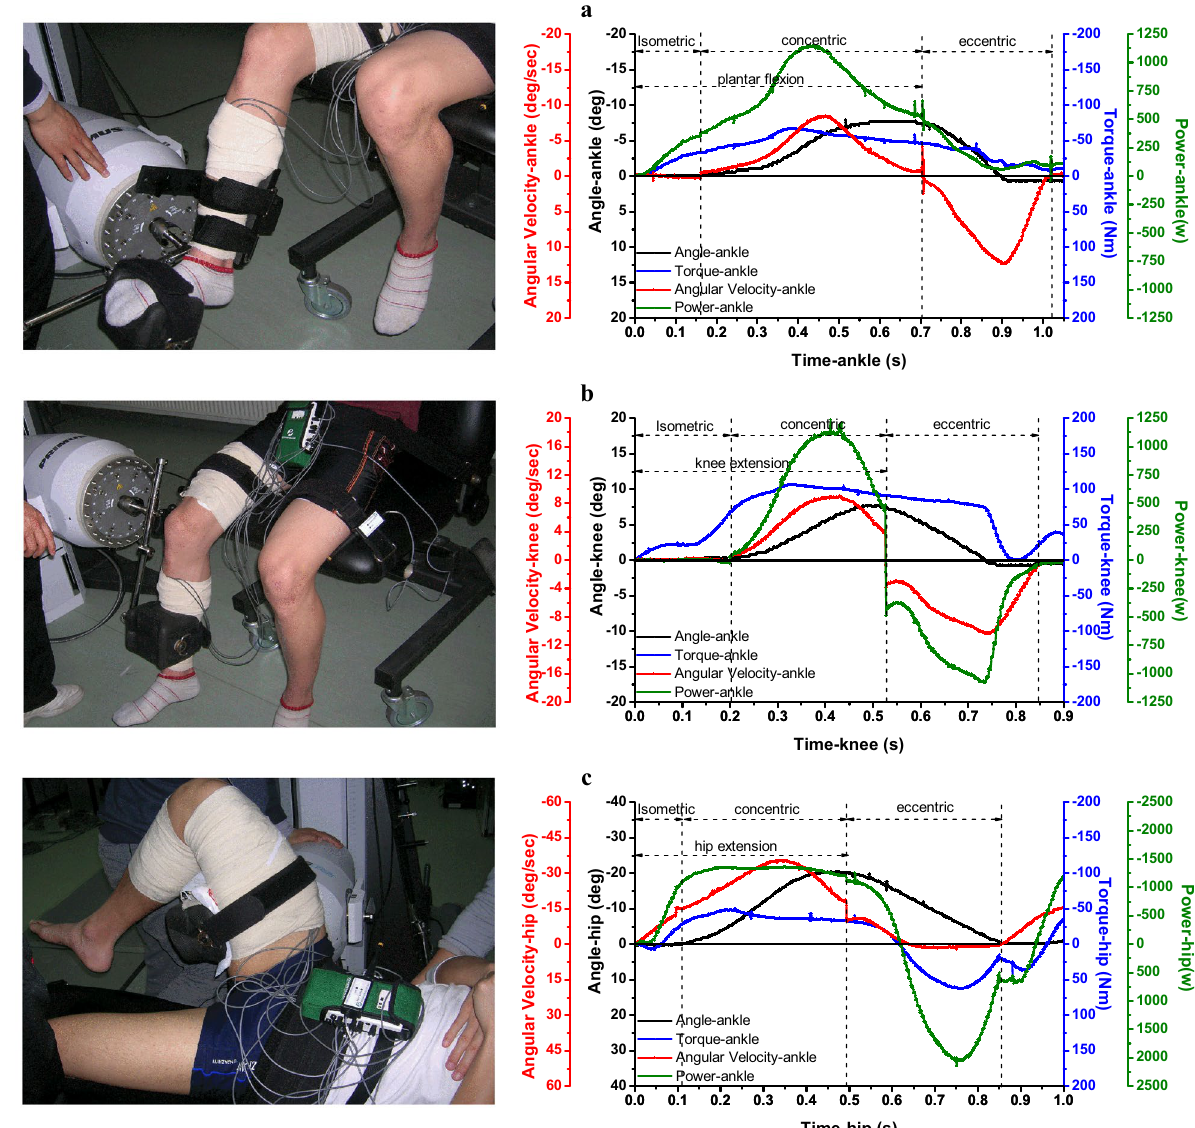
Figure 1. The change of angle, angular velocity, torque and power output with time during each cycle of the IME test for plantar flexors and knee and hip extensors. Note IME, isotonic muscular endurance. Each cycle included a limb loop in which a limb moves from the starting position to the ending position and then returns to the starting position. The angular presented a bell-curve, indicating that the limb loop moves from the starting position to the ending position, and then returns to the starting position. Correspondingly, with the two acceleration and deceleration movements of the limb segment, and the angular velocity presents two bell-shaped curves with opposite